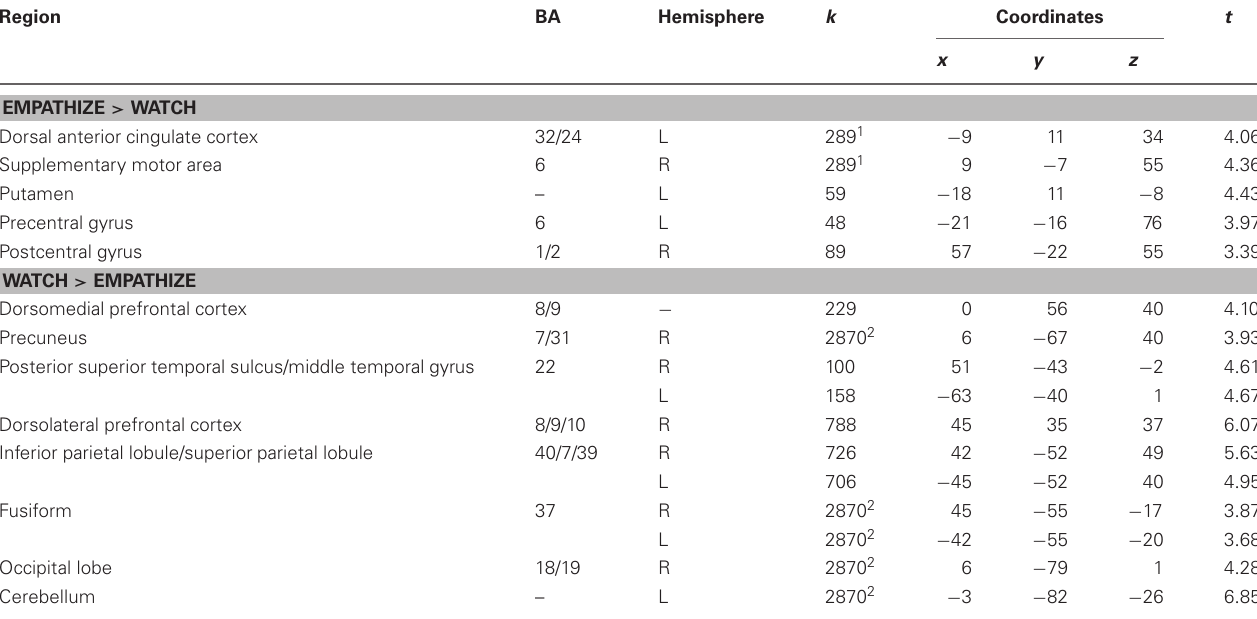
Table 4 | Neural regions that were more active for empathize compared to watch (collapsing across emotions), as well as neural regions that were more active for watch compared to empathize (collapsing across emotions).